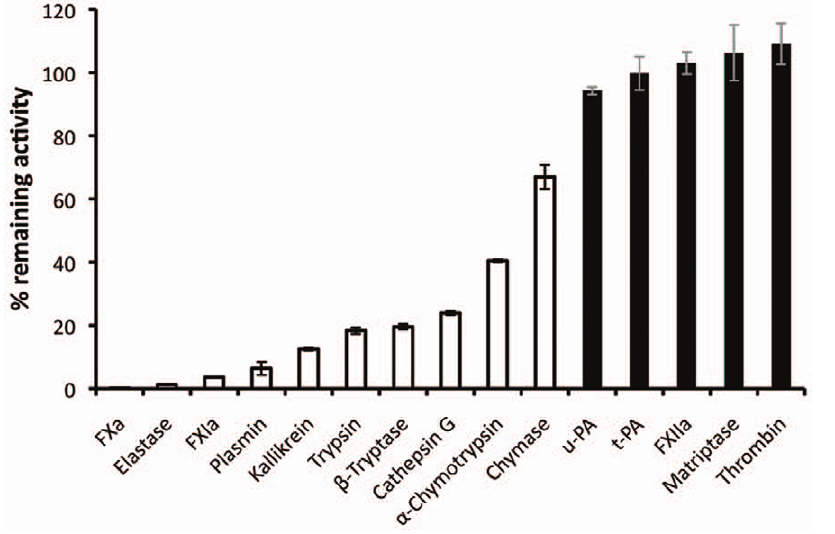
Figure 5. rSimukunin inhibits several serine proteases. Enzyme activity in the presence of 500 nM of rSimukunin, as a percentage of the total activity in the absence of inhibitor, is shown. Results with statistically significant (t-test, p , 0.01) inhibition compared to the control are shown in white bars. The graph shows mean 6 SEM. u-PA: urokinase-type plasminogen activator, t-PA: tissue plasminogen activator. Each inhibition assay was conducted in triplicate.